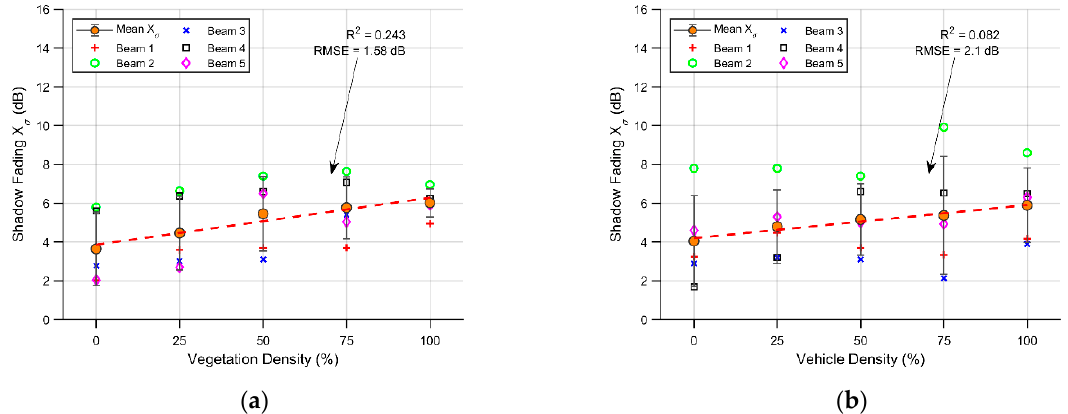
Figure 8. Density effects on the PLE: ( a ) different vegetation densities; ( b ) different vehicle densities.